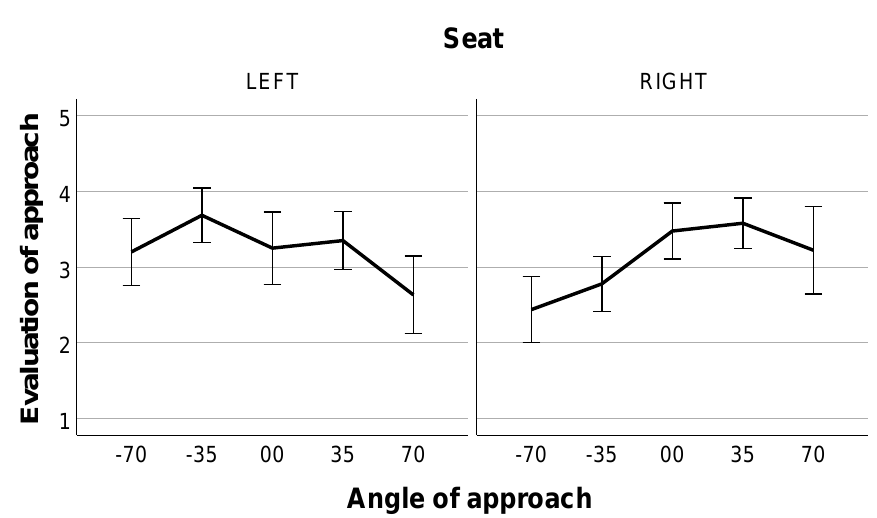
Figure 5. Average evaluation ranging from 1 (very bad) to 5 (very good) per angle of approach (ranging from − 70 ◦ to + 70 ◦ ) and seat in study 2: Whiskers represent 95% confidence intervals.